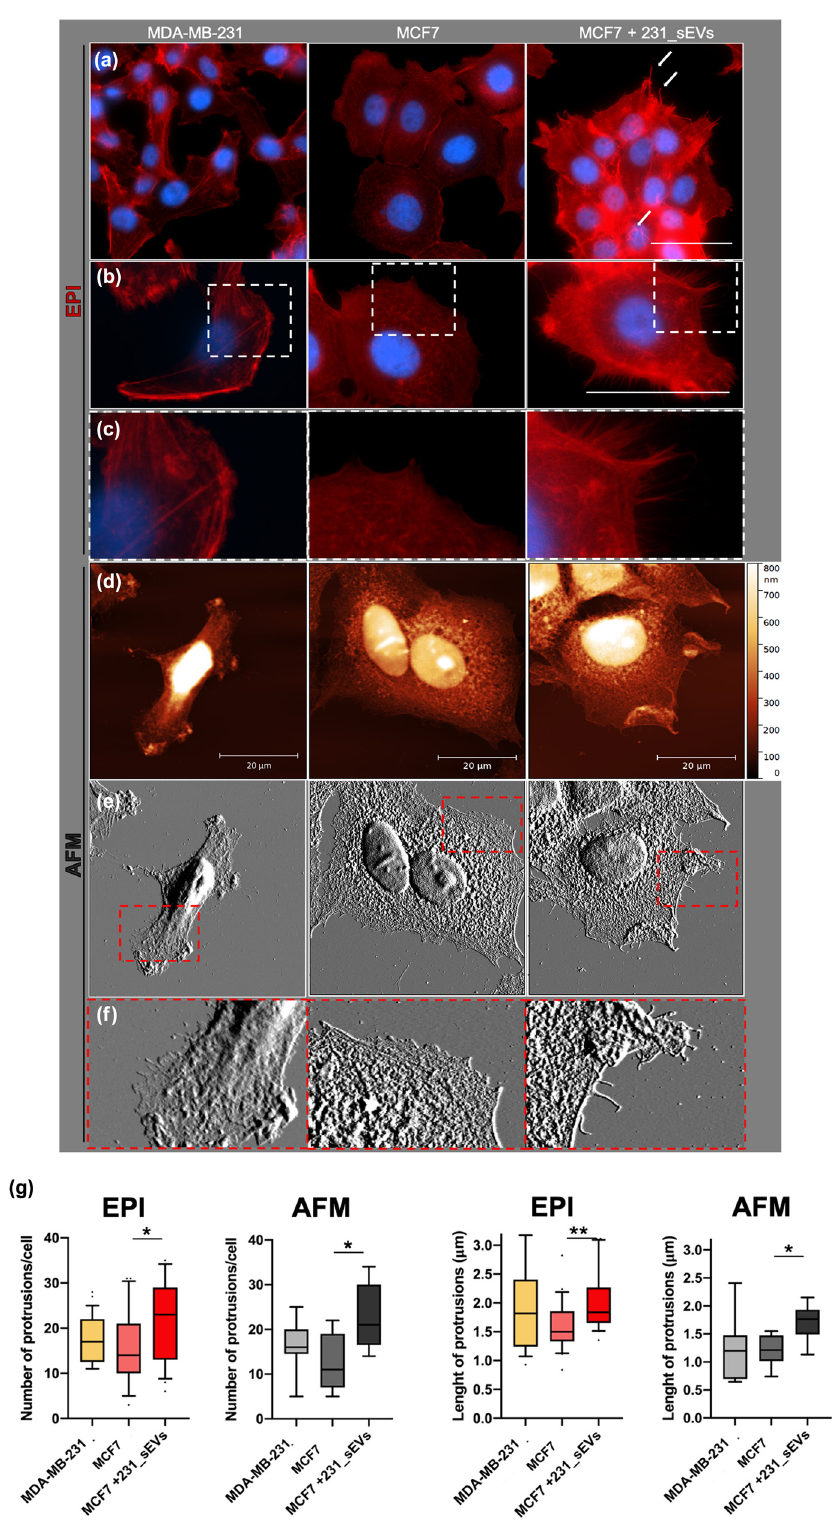
Figure 1: Cellular protrusions of MDA - MB - 231, MCF7, and 231_sEV - treated MCF7 cells. Representative epi fl uorescence images of cells stained with phalloidin ( red ) and DAPI ( blue ) and the corresponding boxplots on bottom ( Row a – b – c – g ) ; scale bar indicates 50 µm; representative heights ( Row d ) and amplitude ( Row e – f ) images obtained from AFM imaging of cells and the corresponding boxplots in the bottom ( Row g ) ; dotted images and white arrows show in detail cellular protrusions. The lower and the upper boundaries of the box represent Q1 ( 25 percentile ) and Q3 ( 75 percentile ) of the data, respectively; the horizontal bar inside the box represents the median of the data. The signi fi cance of data di ff erences was established via ANOVA Kruskal - Wallis test ( * p < 0.05; ** p < 0.01; *** p < 0.001; **** p < 0.0001, respectively )